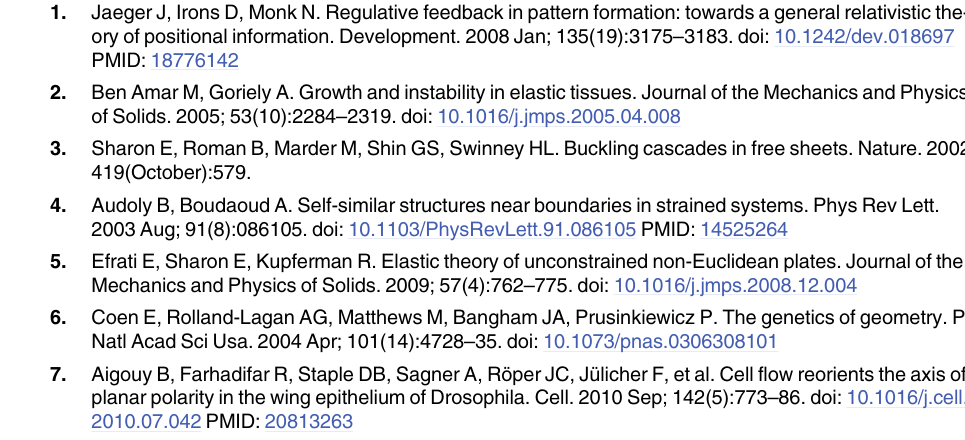
S7 Fig. The mapping from the vein creation stage to the reorganization stage. In the left pic- ture each vein and areole contains hundreds of cell walls which are smaller than the resolution of the image. In the right picture each vein is mapped to a viscoelastic rod, and background tis- sue is completely